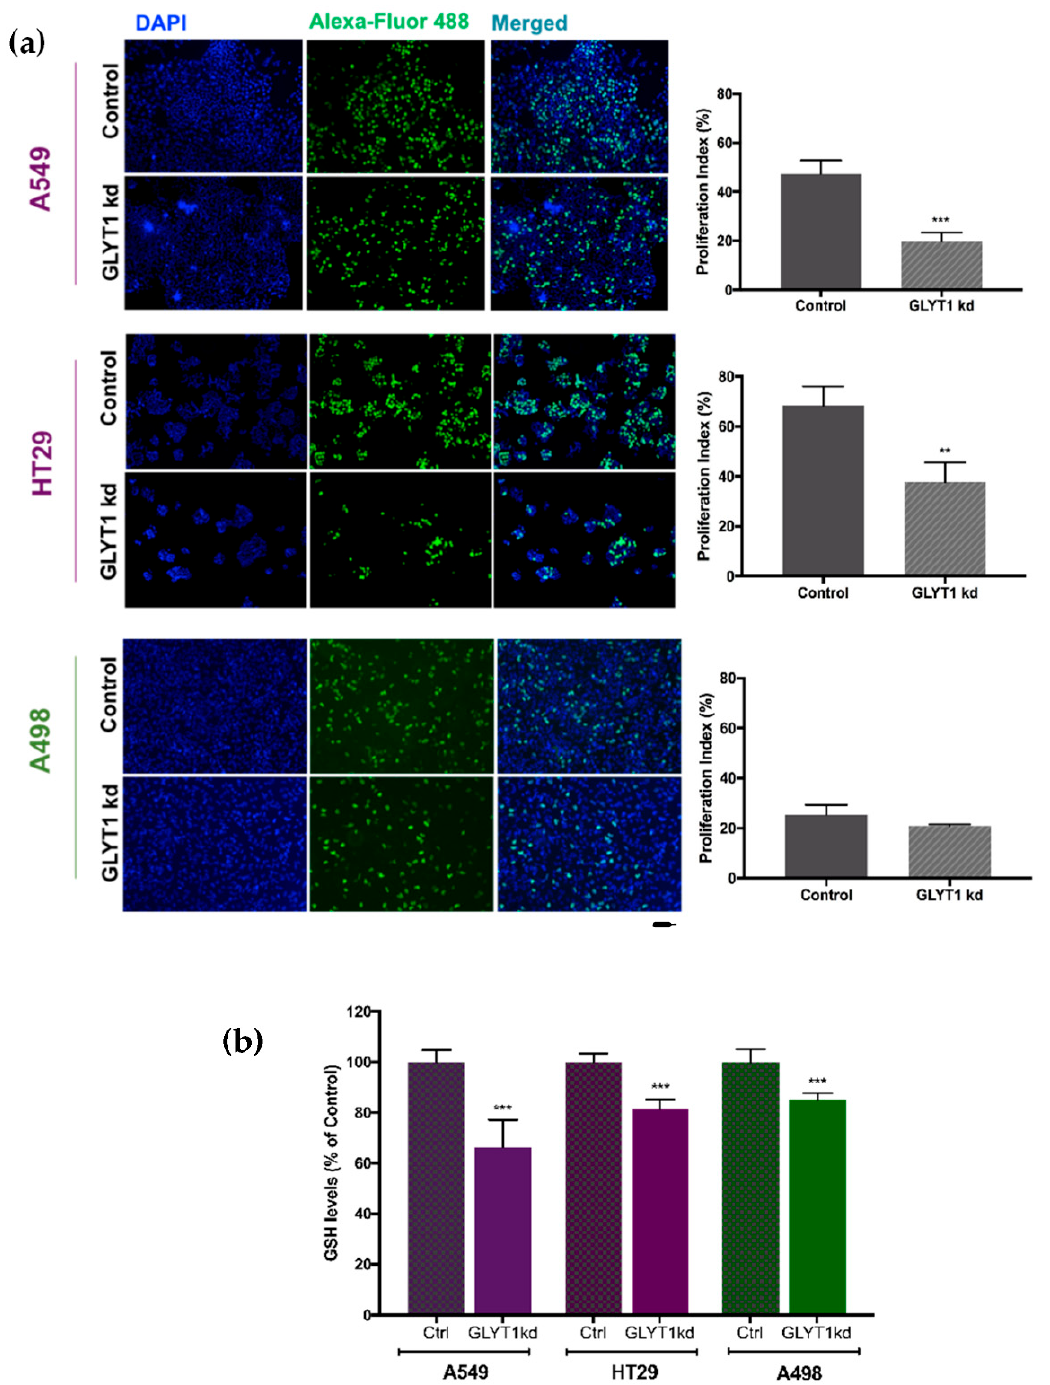
Figure 3. GLYT1 knockdown effect on DNA replication and on GSH levels. ( a Left panel) Fluorescence microscopy images of total nuclei stained with DAPI (blue) and proliferating nuclei stained with EdU labelled with AlexaFluor ® 488 (green) utilising Click-It EdU assay. Bar indicates 50 µ m. ( b Right panel) Four photographs were randomly selected for each group, Control and GLYT1kd, and number of total nuclei and proliferating nuclei (EdU) were counted utilising ImageJ program. The percentage of proliferation index was calculated (proliferating nuclei/total nuclei number × 100). Data represent mean ± SEM, n = 4. Statistical analysis comparing treatment (GLYT1kd) and control of each cell line was performed by unpaired t-test where p < 0.01 (**) and p < 0.001 (***). ( b ) GSH levels analysed following 72 h transfection with Negative siRNA (control) or GLYT1 siRNA (GLYT1kd) by GSHGlo assay (Promega). Data presented as percentage of control mean ± SEM, N = 2, n = 6 per group. Statistical analysis comparing treatment (GLYT1kd) and control of each cell line was performed by unpaired t-test where p < 0.001 (***).